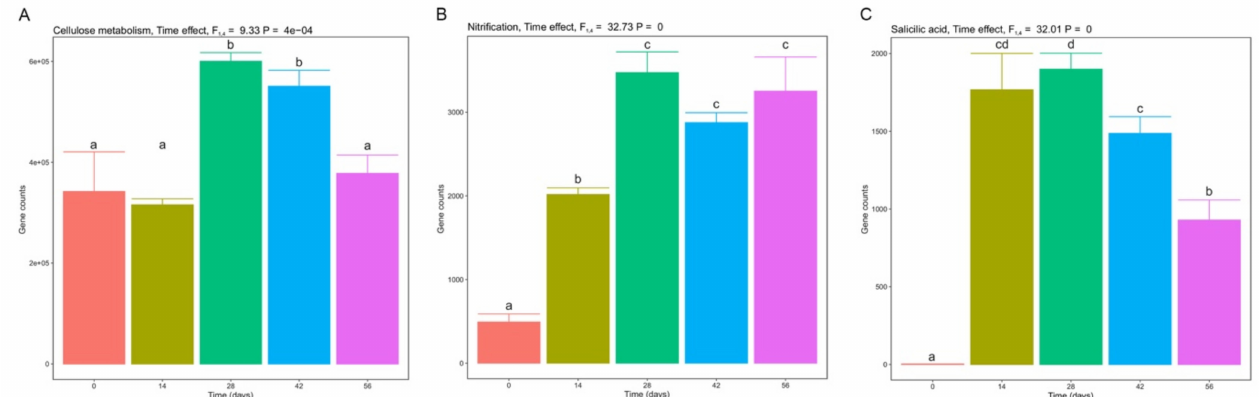
Figure 5. Changes in gene abundance of PICRUSt-predicted KEGG orthologies implied in cellulose metabolism ( A ), nitrification ( B ), and salicylic acid synthesis ( C ) during vermicomposting of the silver wattle. Values are presented as means ± standard error ( n = 5). Above each plot, results from mixed-effects models are shown. Letters indicate significant differences between time points (Tukey HSD